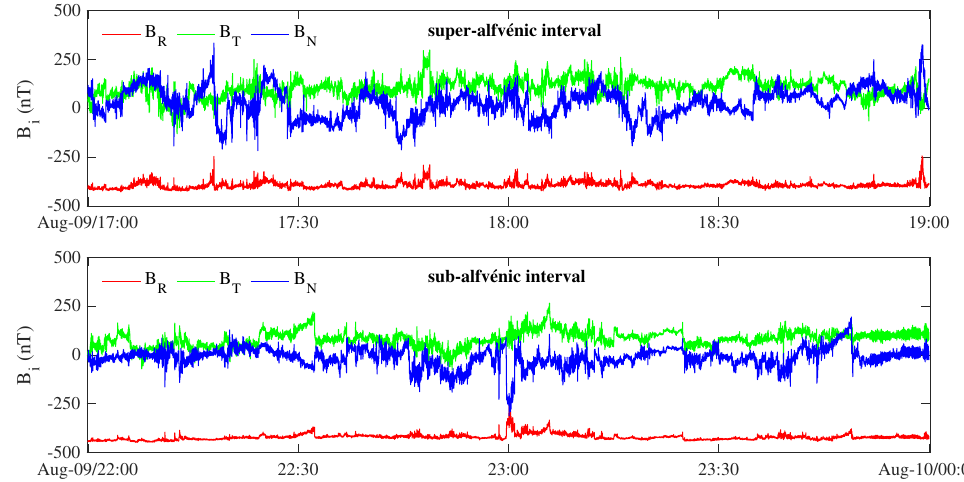
Figure 1. The three magnetic field components in the radial–tangential–normal (RTN) reference system for the two intervals considered in this study: ( upper panel ) the super-alfvénic, and ( lower panel ) the sub-alfvénic solar wind,